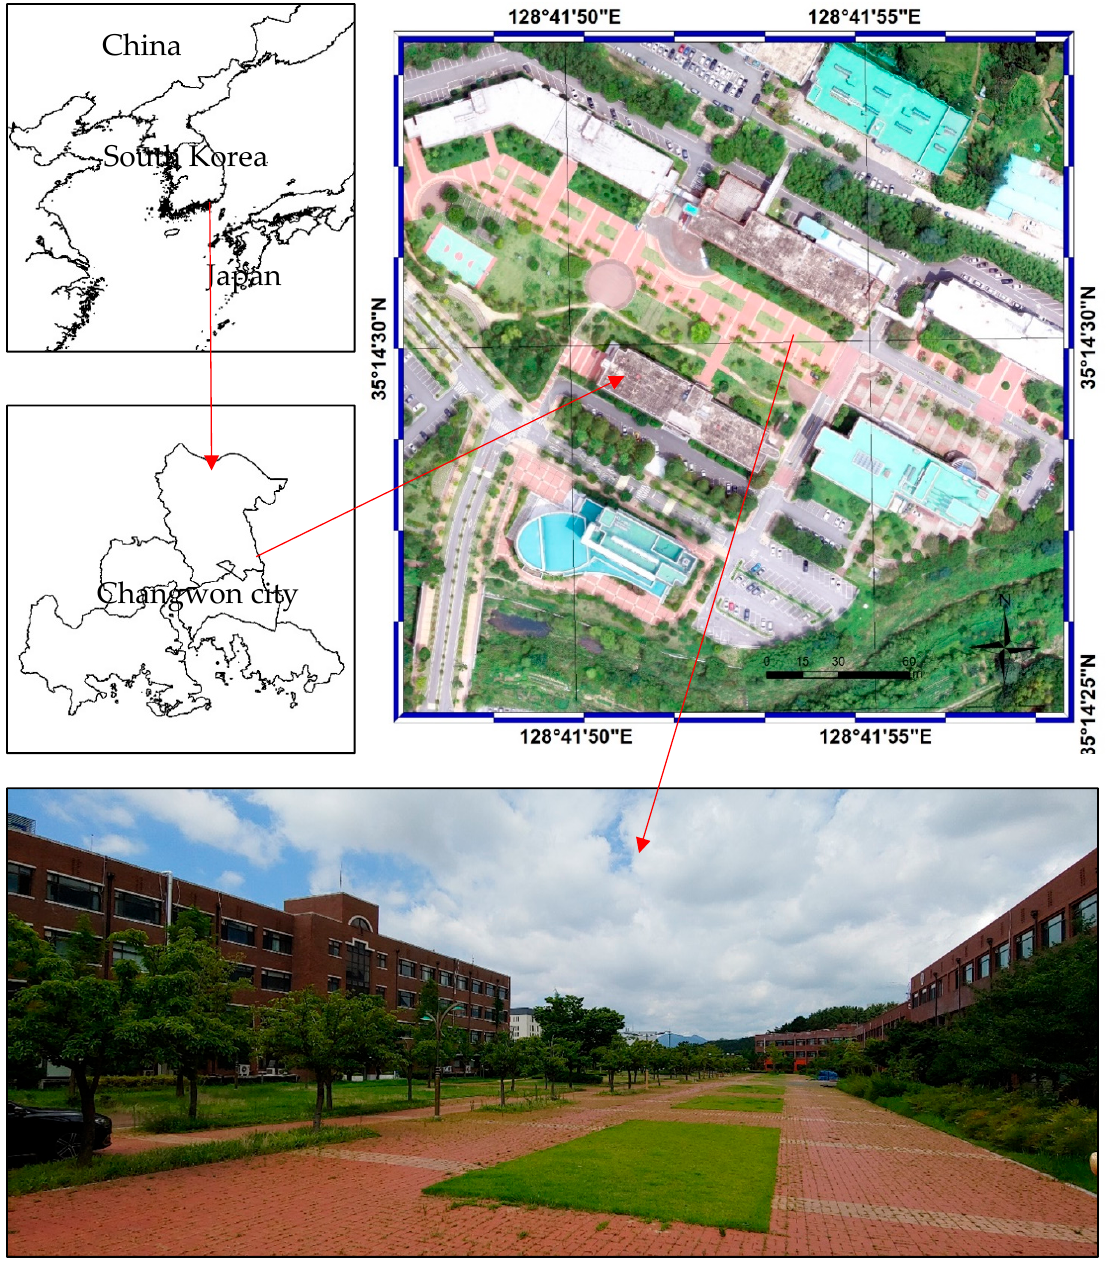
Figure 1. Location map and images of the study area (Changwon National University Campus) .